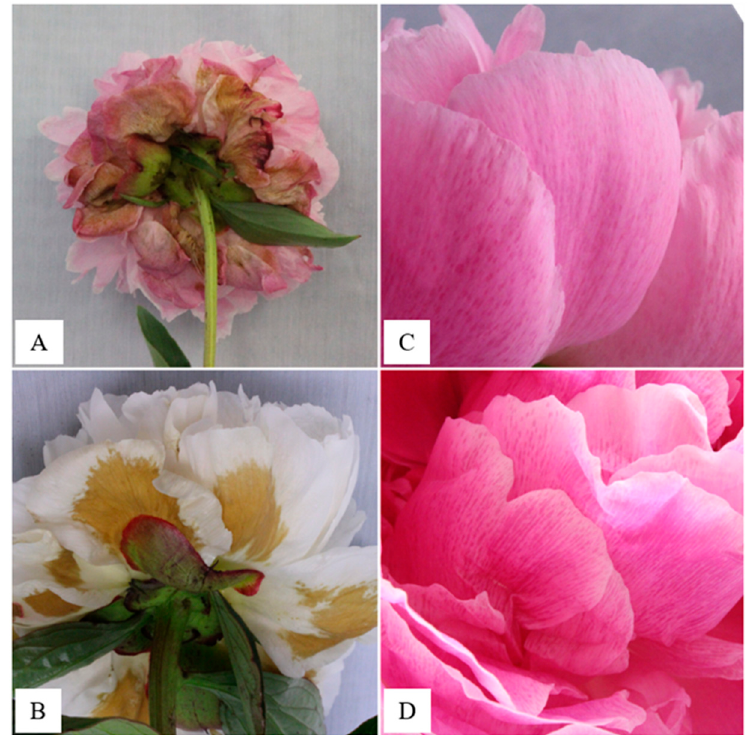
Figure 4. Petal injury in select Paeonia lactiflora cultivars. Necrosis was primarily observed on the outer petals of ( A ) ‘Sarah Bernhardt’ and ( B ) ‘Festiva Maxima’ when stored above 0 °C. Water-soaked spotting, pictured on ( C ) ‘Monsieur Jules Elie’ and ( D ) ‘Sarah Bernhardt’, developed on all cultivars following storage at − 3.1 °C.